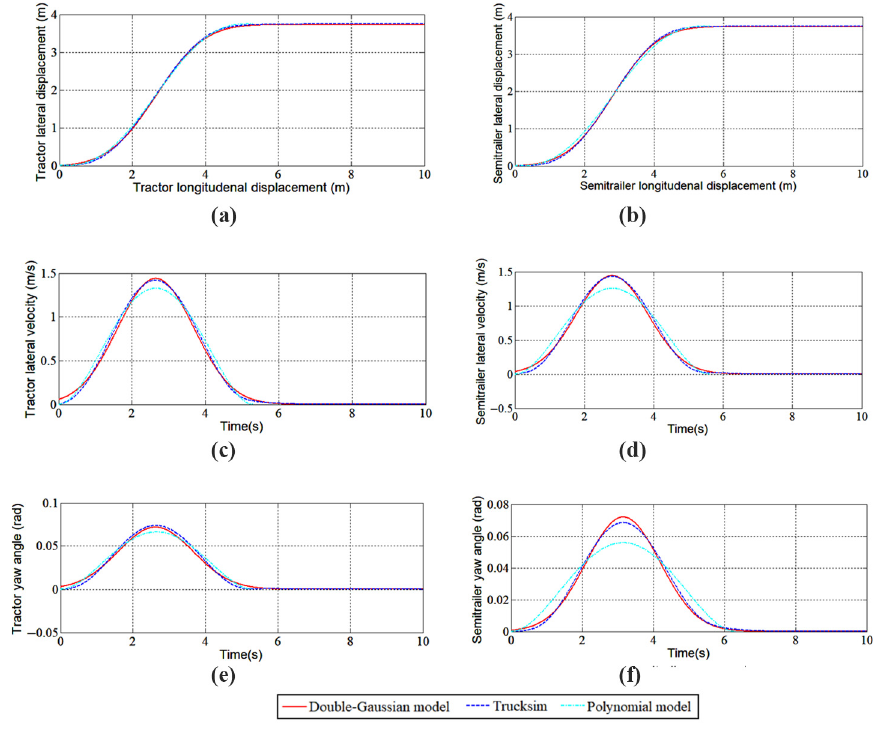
Figure 5 Contrasts in constant longitudinal velocity